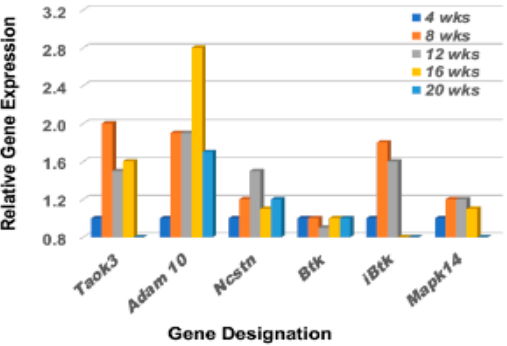
Figure 3. Differential expression profiles for genes encoding various factors involved in the upreg- ulation of MZB cell signal transductions. Comparative transcriptome data showing the temporal expression of genes encoding factors critical in regulating the Notch2 signal transduction pathway of MZB cells, i.e., Taok3 (TAO kinase 3), Adam10 , Ncstn (Nicastrin), Btk (Bruton’s tyrosine kinase), iBtk (Inhibitor of Bruton’s tyrosine kinase), Prp38 (Proline rich protein 38), and Mapk14a (Mitogen- activated protein kinase 14a) active in lacrimal glands of C57BL/6.NOD- Aec1Aec2 mice starting at 8 wks of age.